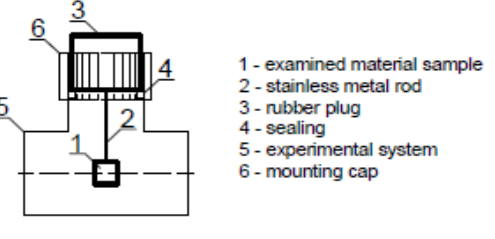
Figure 2. The scheme of the tested sample.